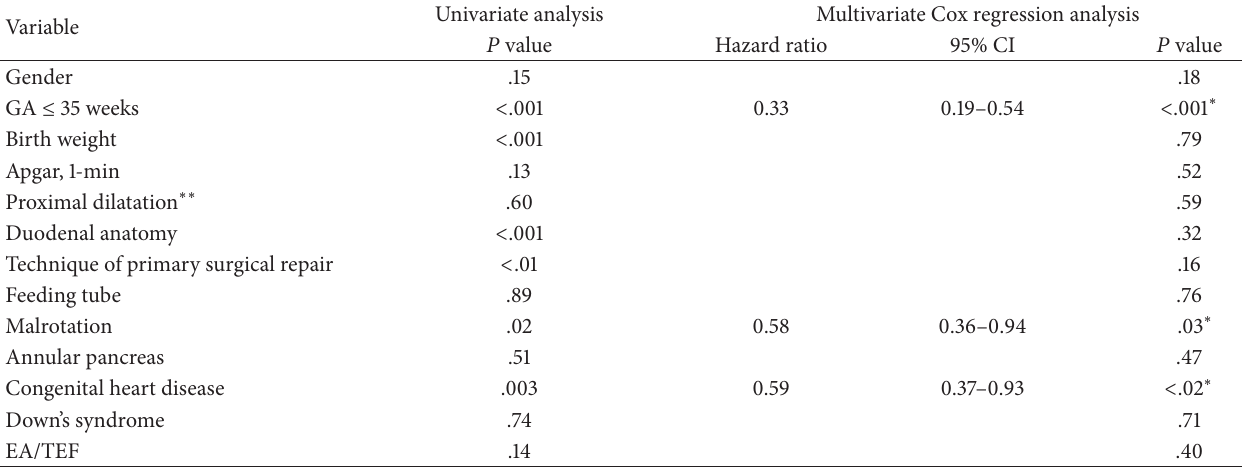
Table 3: Predictors of delayed transition to full enteral nutrition.